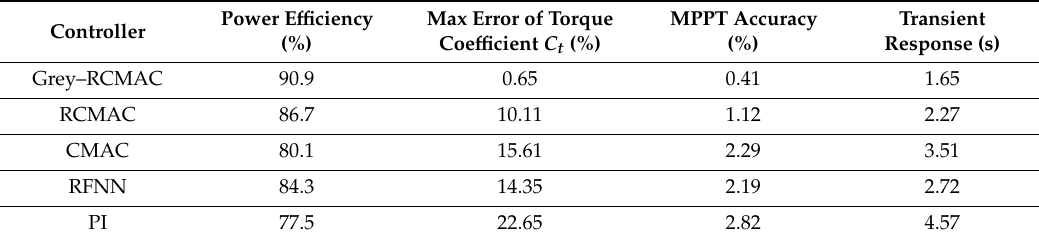
Figure 3. Output power tracking response of the WECS. Table 1. Performance comparison of power extraction with five control methods.